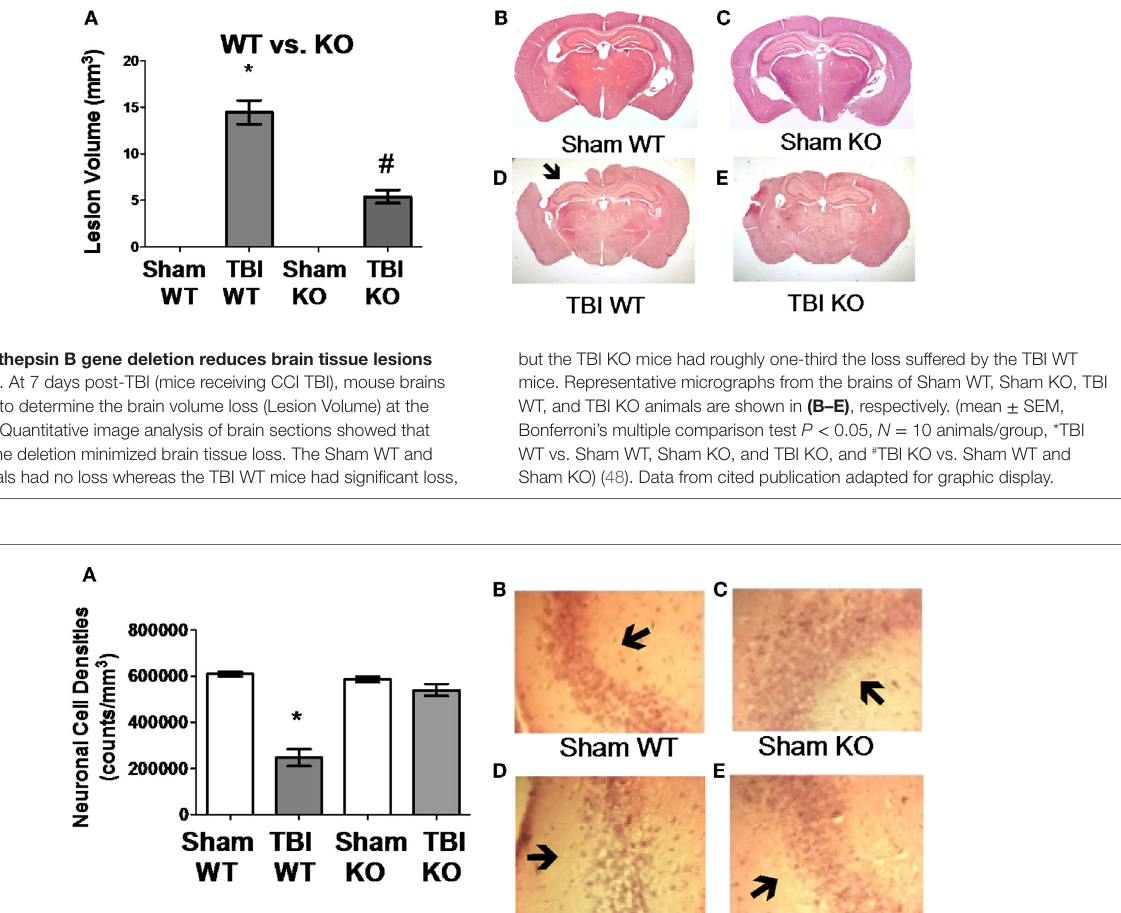
FiGURe 4 | Cathepsin B gene deletion reduces neuronal loss after TBi . Quantitative image analyses of brain sections evaluated for Lesion Volume were also analyzed for neuronal cell density in the CA3 region of the hippocampus, which is distal to the impact site. (A) TBI WT, but not TBI KO, mice had lower neuronal density than Sham WT and Sham KO animals. Thus, cathepsin B